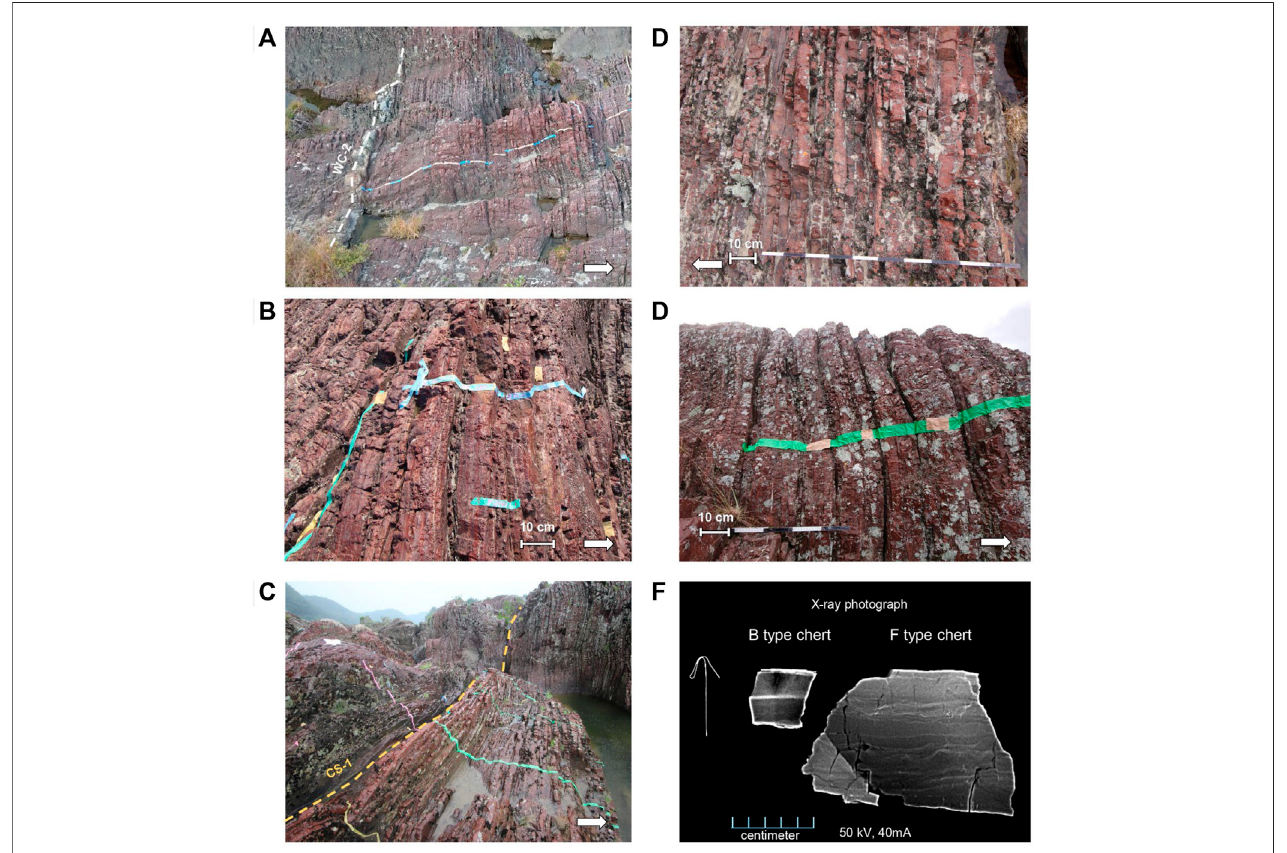
FIGURE3 | Representative outcrop photographs ofthe Carnian bedded cherts (A) White chert WC-2and Julian F-type red chert. The boundaryof red and purple chertcanbeseenontherightsideofthephotograph. (B) Close-upofJulianF-typepurplechert.Millimetertocmscalelaminationandbeddingisobservedaschangesin color and silica content (C) Thick claystone layer CS-1 located at the boundary of F-type purple chert and B-type red chert. (D) Close-up of the B-type red chert (Julian- Tuvalian) with relatively thick intercalated mudstones. (E) Close-up of the F-type red chert (Tuvalian). The Intercalated mudstones of the F-type cherts are very thin ( < 5 mm). (F) Soft X-ray photograph of B-type (Julian-Tuvalian) and F-type (Tuvalian) chert. Thick intercalated mudstones are observed on the B-type chert whereas millimeter scale lamination can be seen on the F-type chert. Tape width in (A,C,E) is 5 cm. Scale bars are 10 cm. The white arrows indicate way-up.